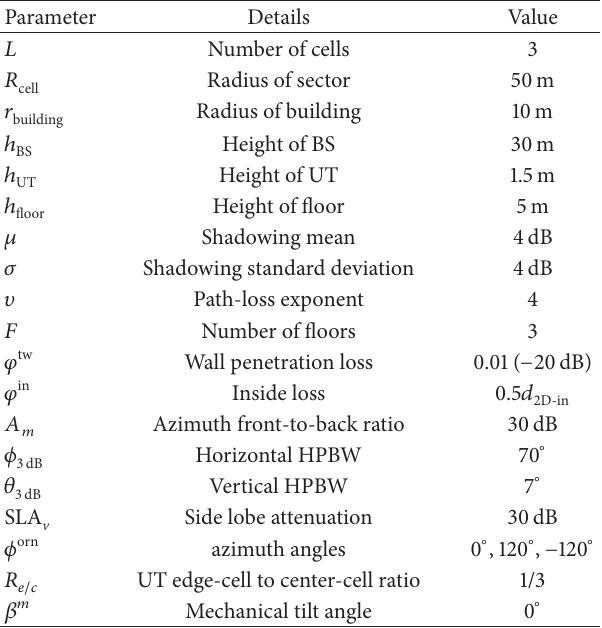
Table 1: Value of parameter in